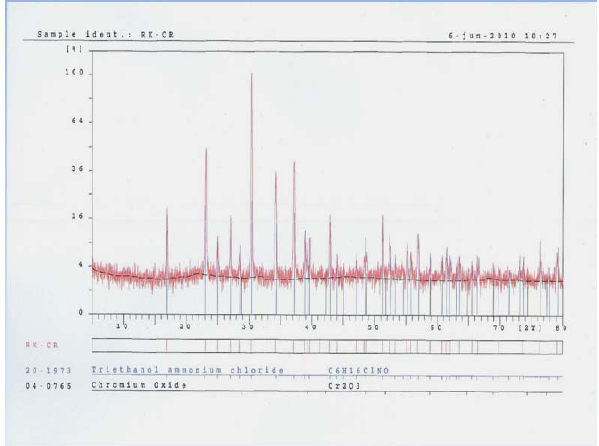
O nanoparticles 2 3